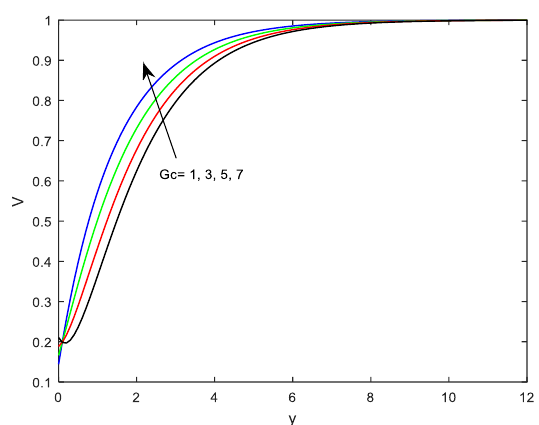
Fig. 6. Profiles of V with a change in